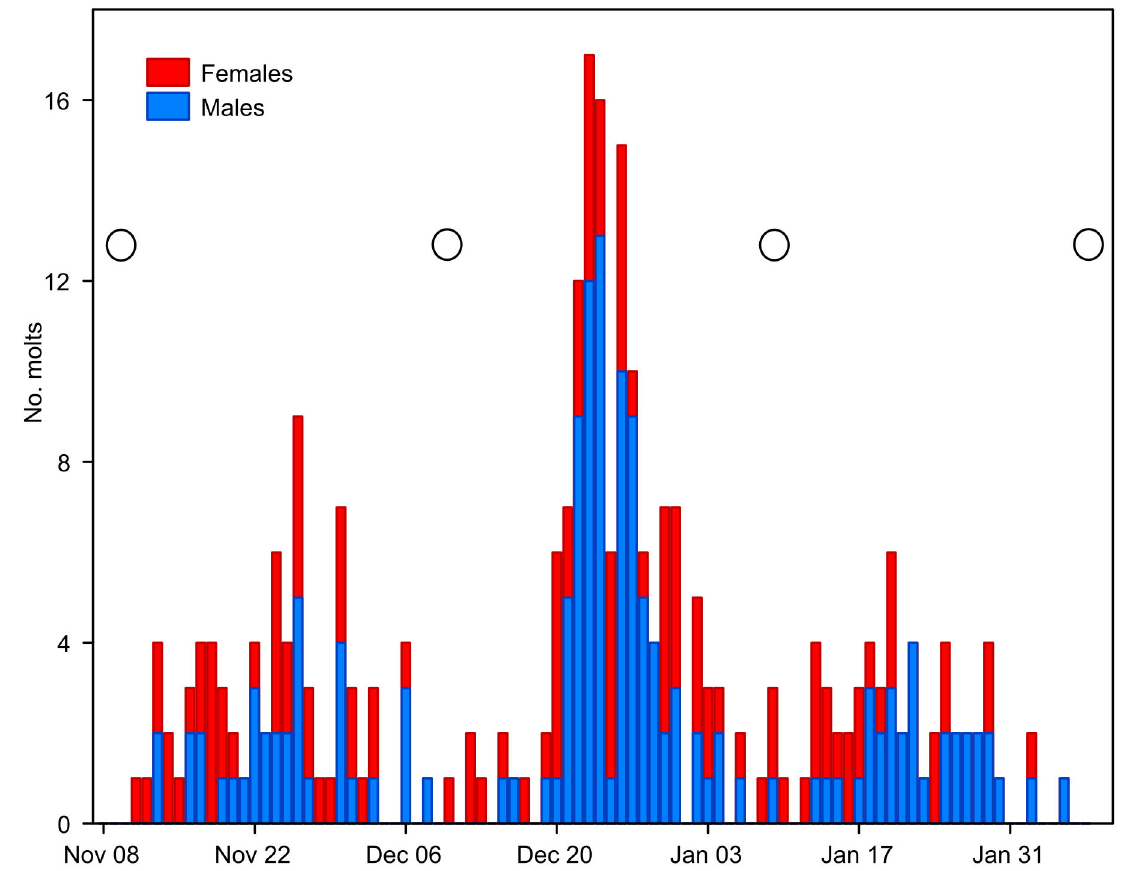
Figure 1. Daily molt frequencies of males and females over the three-month experimental period (experiment 1). Stacked bar plot; days of full moon indicated by open